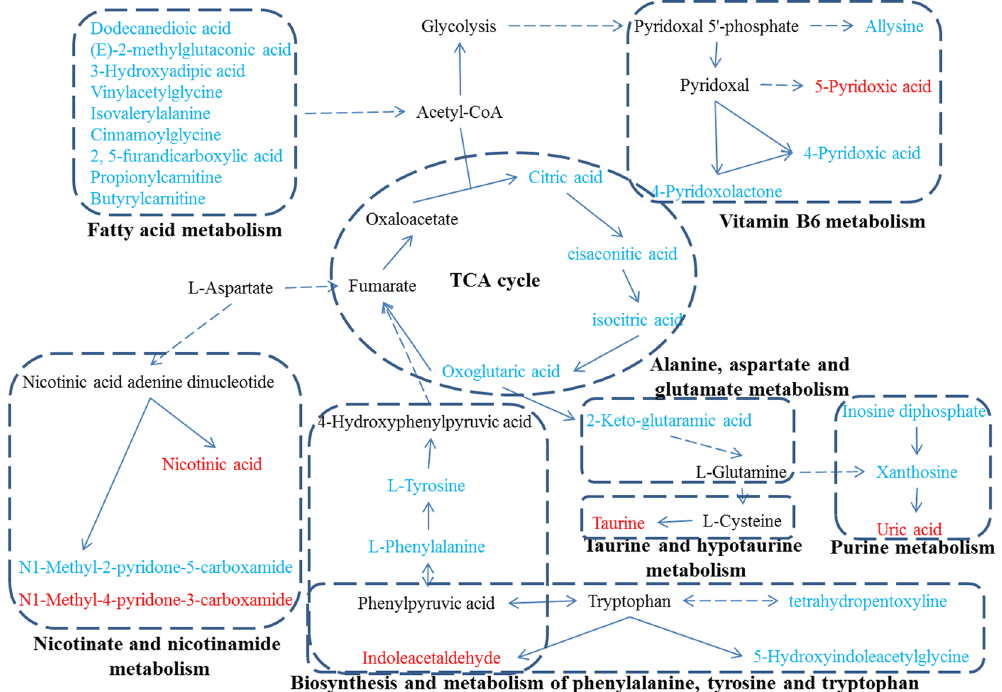
Figure 7. The metabolic pathway networks of potential biomarkers (PBs) in response to the toxicity- attenuation effects of HuangQi Injections on cisplatin-exposed rats. The identified PBs are labeled in blue (up- regulated in Group CDDP) and red (down-regulated in Group CDDP),